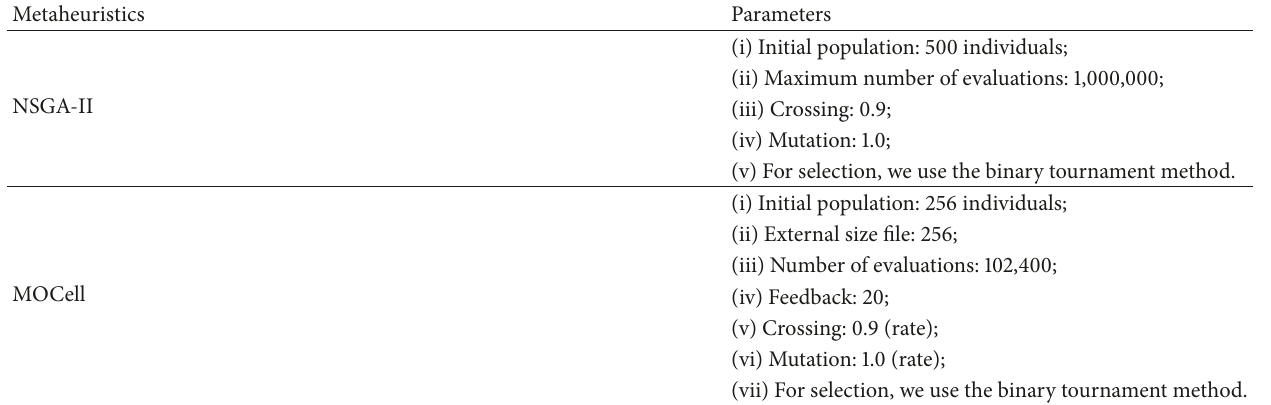
Table 3: Metaheuristic